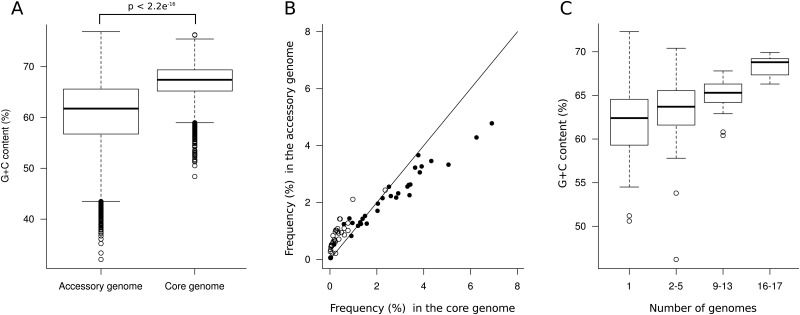
Comparison of the G+C content, codon frequency between core and accessory genome and genetic drift of prophage elements.(A) Comparison of the G+C content between core and accessory genome. The box plots represent the first and third quartiles for each n value, the solid line indicated the median (61.7% for accessory genes and 67.1% for core genes; two-sided Student's t-test), the whiskers indicate the maximums and the open dots indicate the outliers. (B) Codon frequency (%) compared between core and accessory genome. Open circles indicate codons ending with A or T, black circles indicate codons ending with G or C. (C) G+C content of prophage elements according to the number of genomes they are in. The solid line indicated the median (62.4% for unique prophage elements and 68.8% for core prophage elements). The whiskers indicate the maximums and the open dots indicate the outliers.